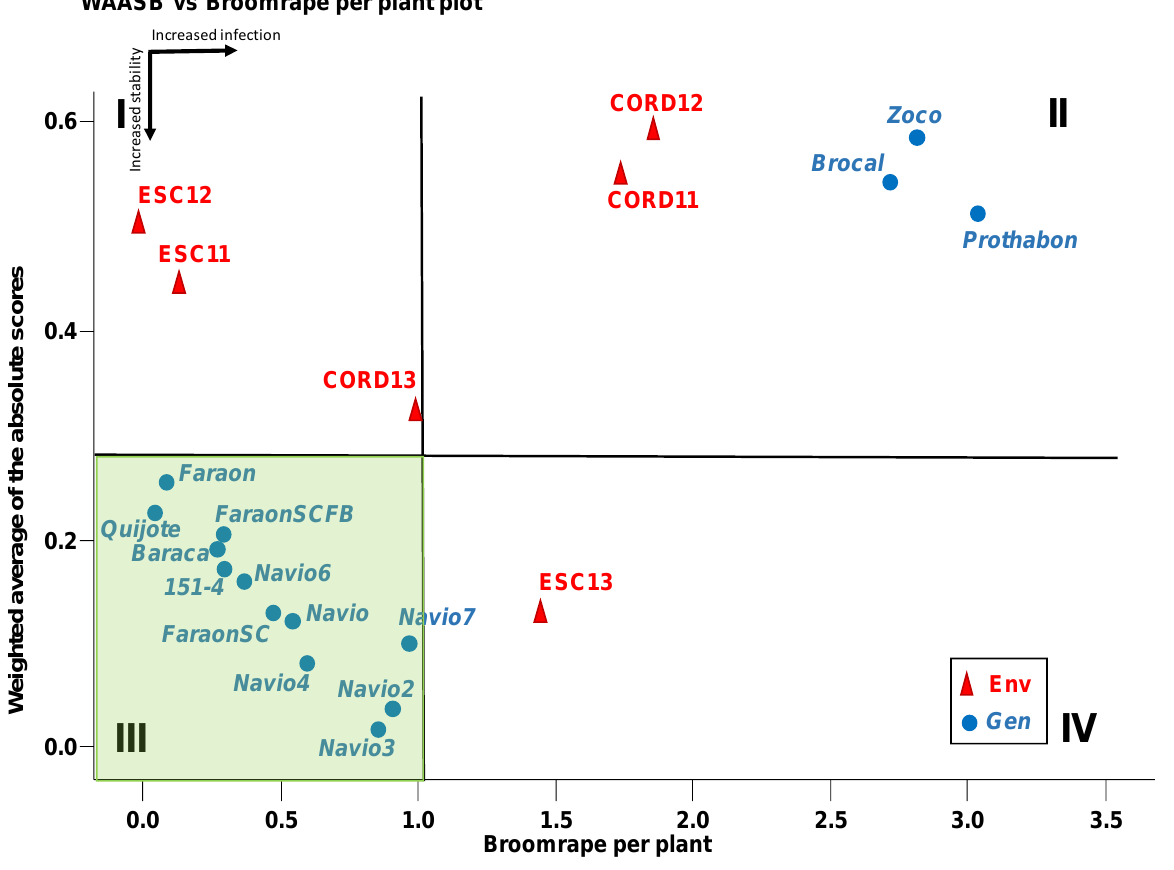
Figure 3. Biplot of the number of broomrape per plant vs. WAASB of 15 faba bean accessions studied in six environments. Horizontal and vertical black arrows indicate the direction of the increase in the number of broomrape per plant and stability, respectively.